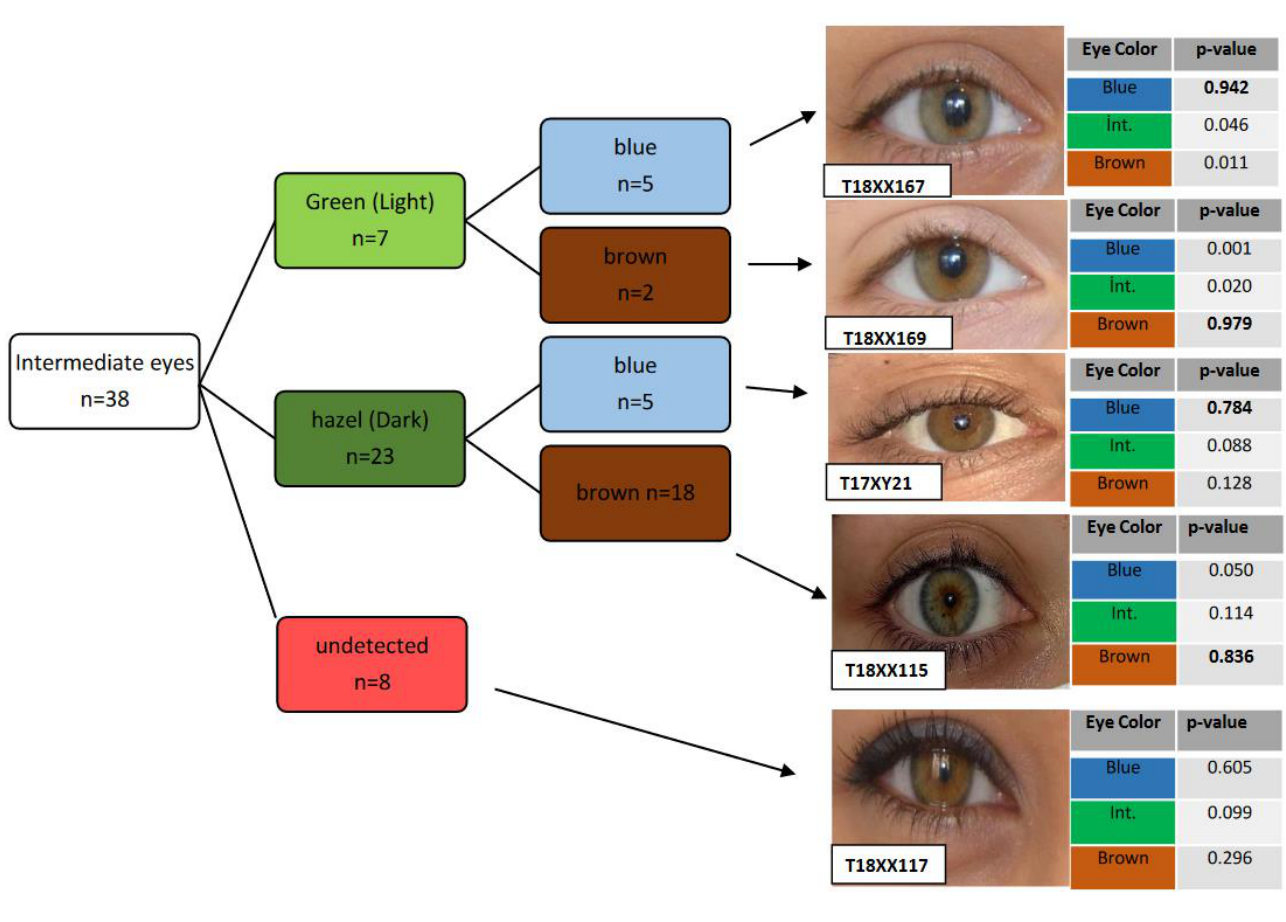
Figure 1. Distribution of the intermediate eye color prediction results. Bold p -values indicated the highest p -value for the predicted eye color. highest p -value for the predicted eye